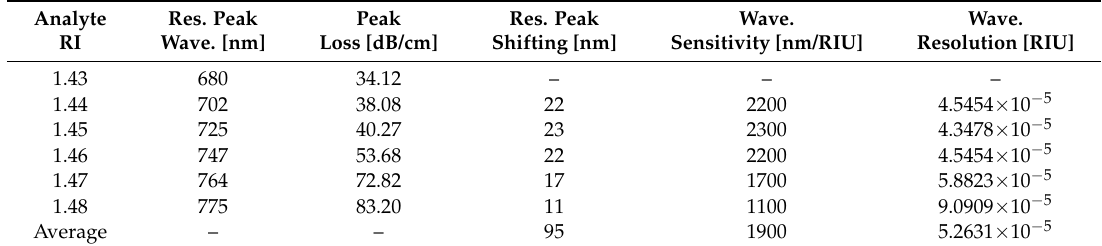
Table 1. A comparison of different parameters for the sensing performance from results in Figure 5. Results are compared for successive refractive index steps and with the corresponding